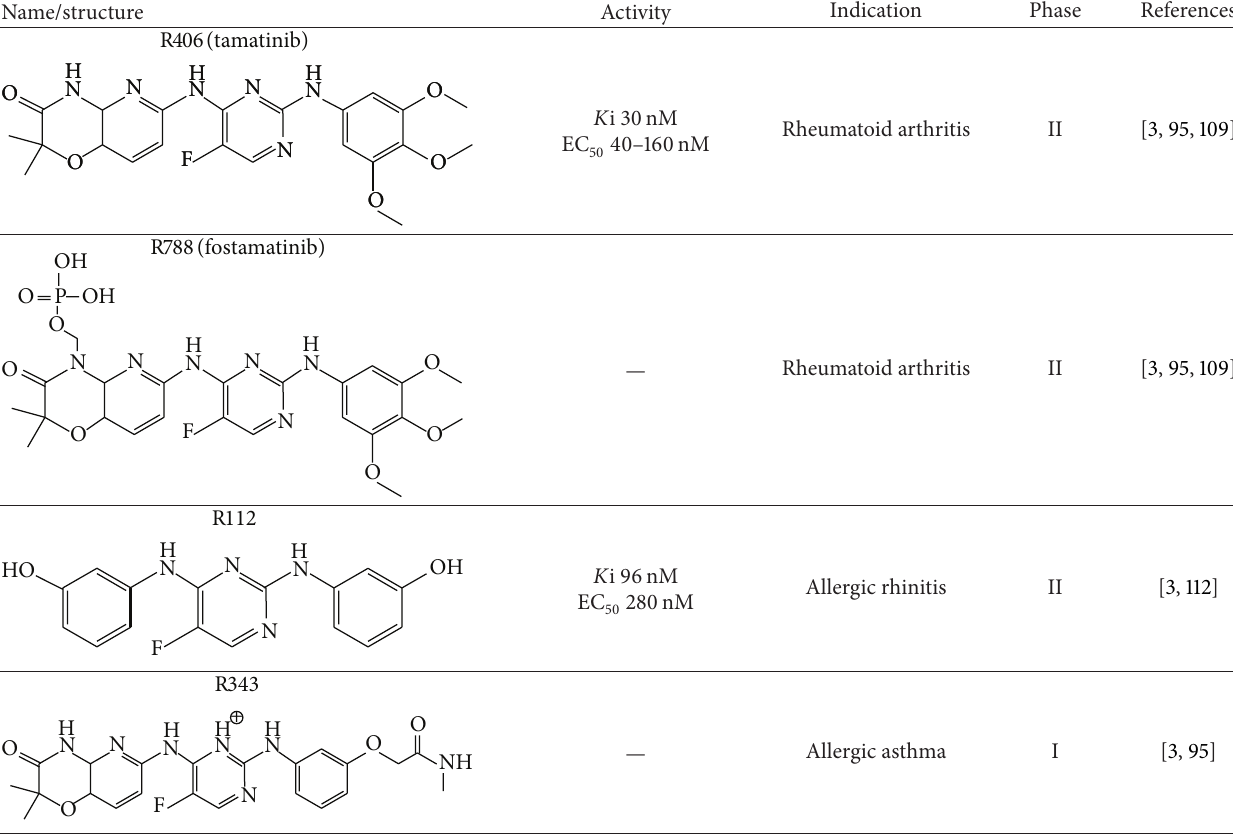
Table 3: Summary of Syk inhibitors in clinical